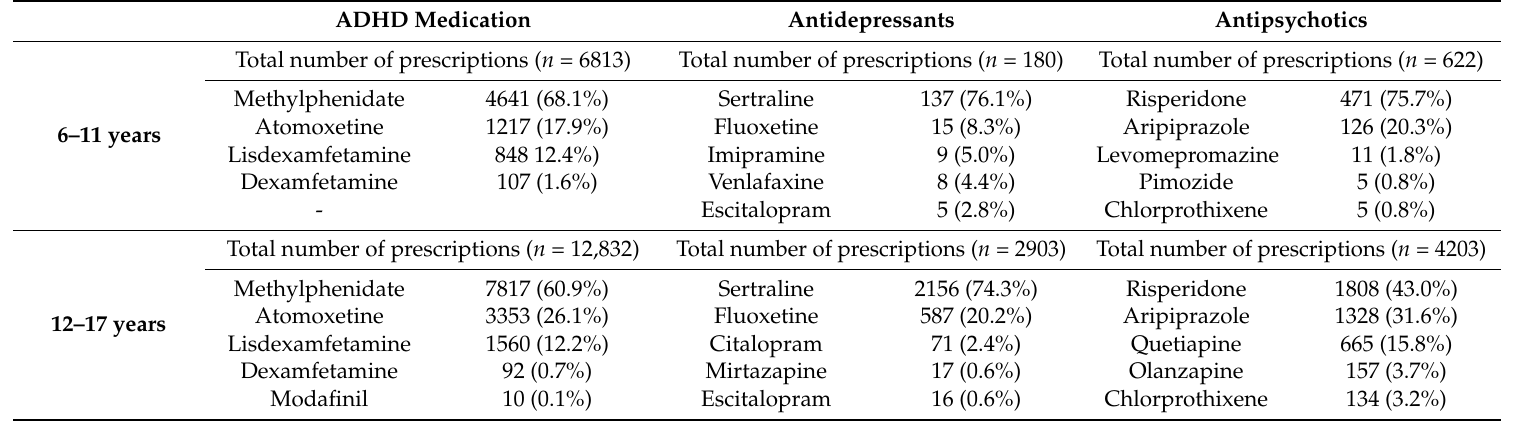
Table 3. The five most commonly used single drug substances within ADHD medication, antidepressants and antipsychotics in 2017 in children and adolescents 6–17 years old with